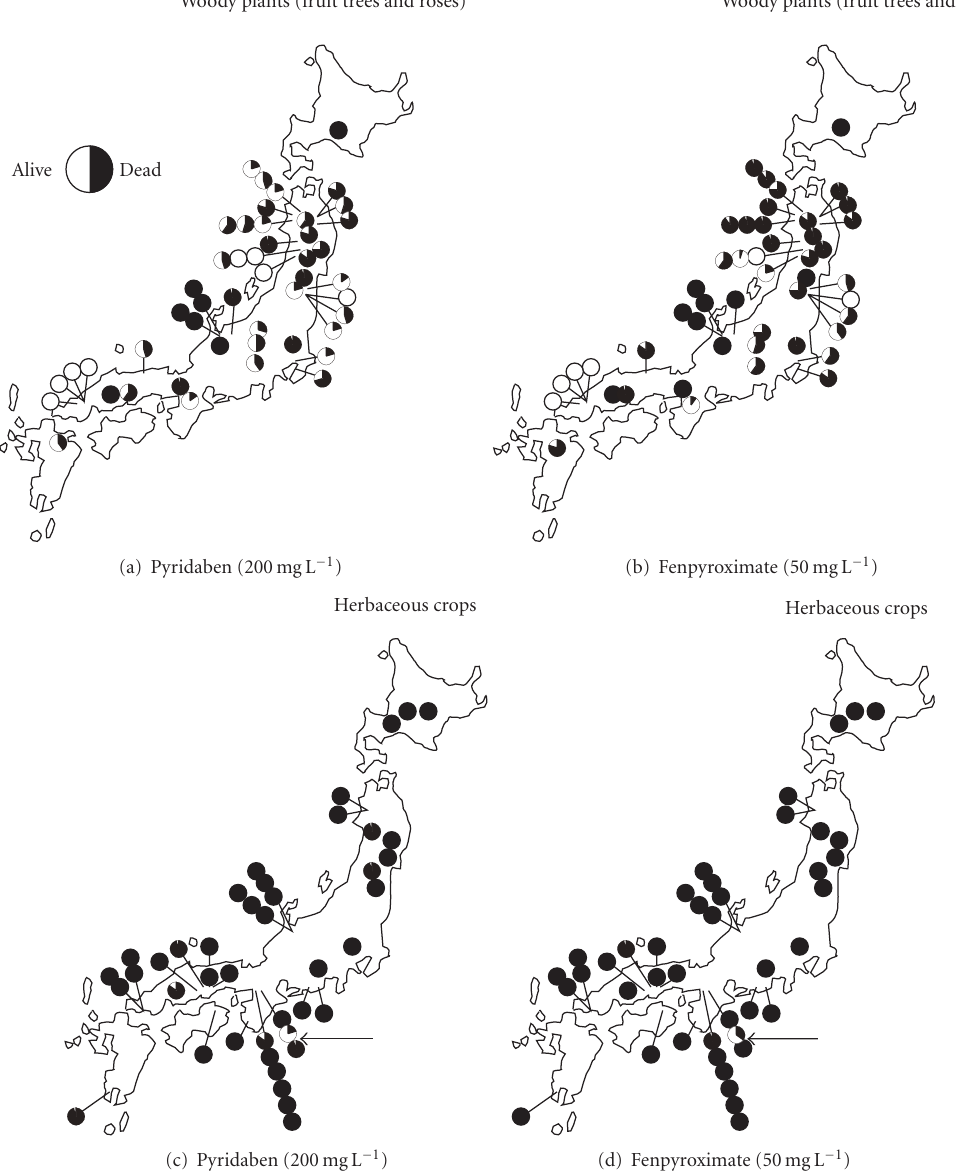
Figure 2: Geographic variation of susceptibility to acaricides in 48 and 42 T. urticae populations collected from woody plants (fruit trees and rose plants) (a), (b) and herbaceous crops (c),